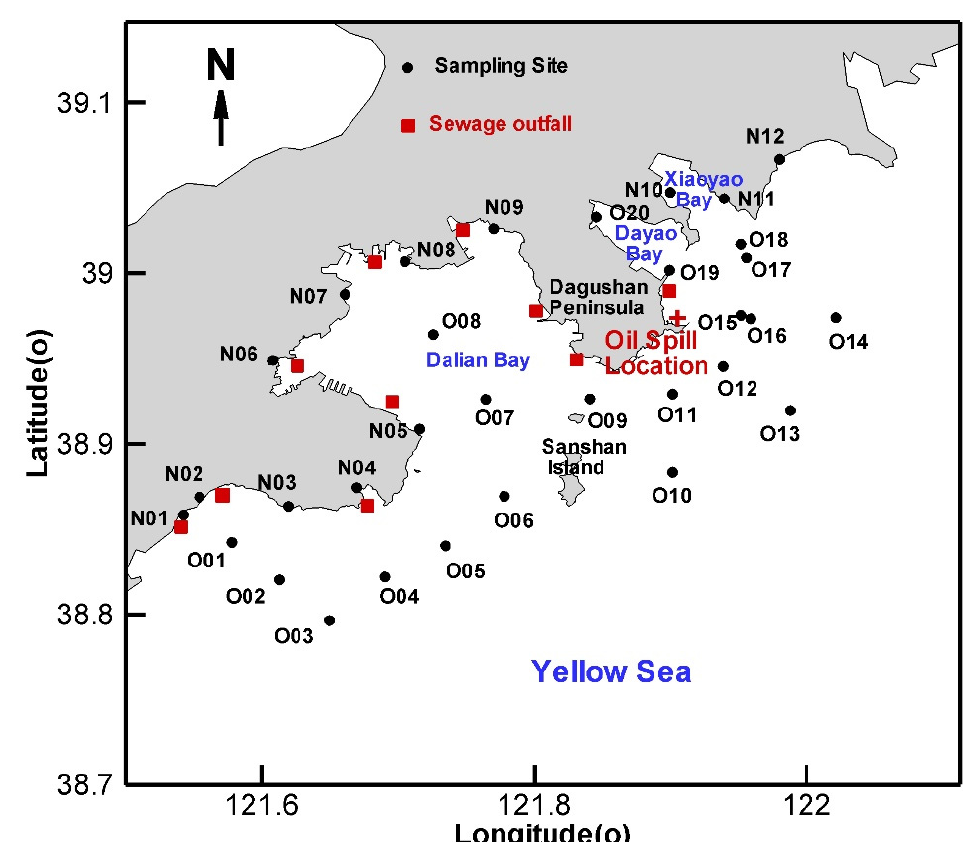
Figure 1. Sampling locations around the Dalian New Port oil spill site.